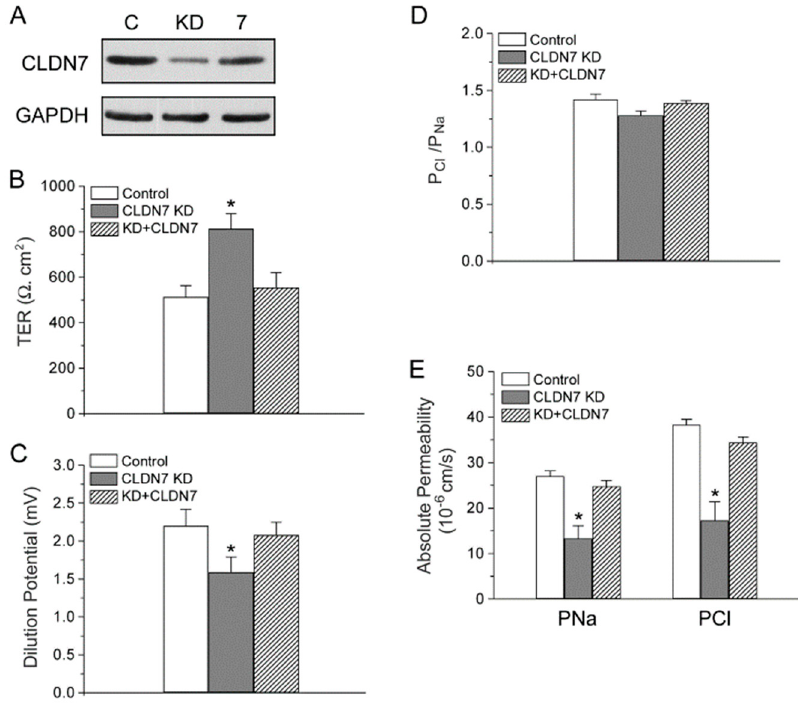
Figure 6. Re-expression (‘rescue’) of CLDN7 in CLDN7 +/+ CD cells with CLDN7 knockdown restored paracellular Cl − and Na + permeability. ( A ) CD cells from control (C), CLDN7 knockdown (KD), KD with CLDN7 cDNA transfection (7) were lysed in RIPA buffer and subjected to western blotting. The membrane was blotted with anti-CLDN7 antibody. ( B ) TER values were measured on cell monolayers cultured for 7 days on collagen-coated Transwell plates. ( C ) Dilution potentials were measured as described in Figure 2B. ( D ) The ratio of the absolute permeability of Cl − to Na + (P Cl / P Na ), and ( E ) the absolute permeability for P Cl and P Na were calculated as described in Figure 2C,D, respectively. * p < 0.05 compared to control and KD + CLDN7. n = 3.